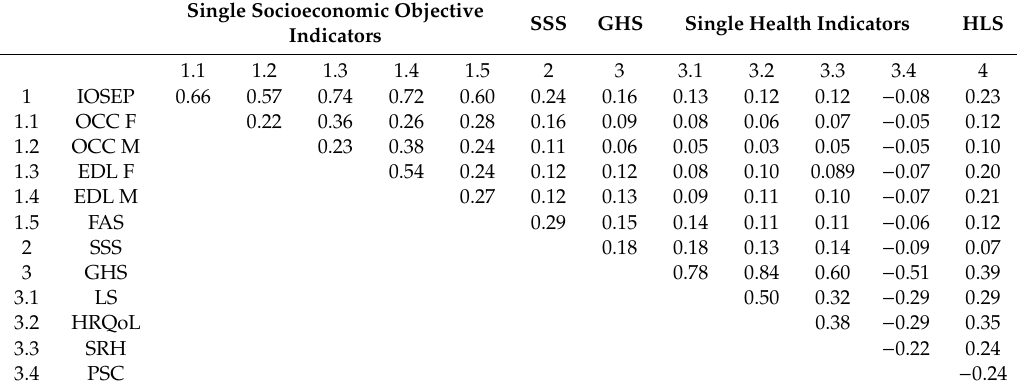
Table 4. Spearman’s correlation coe ffi cients (rho) between socioeconomic indicators, adolescent health, and healthy